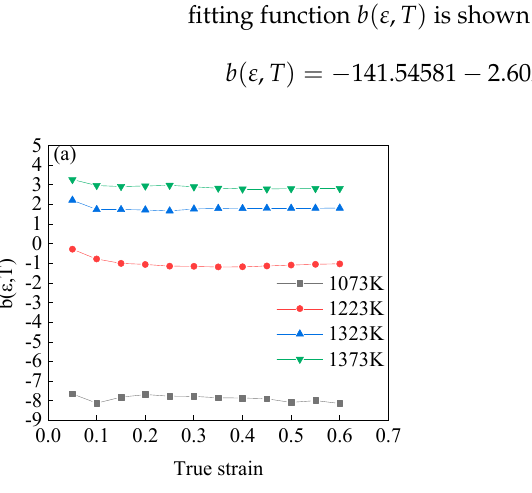
Figure 14. The value of b ( ε ,T ) under different deformation conditions: ( a ) the calculation results, ( b ) the fitting results.